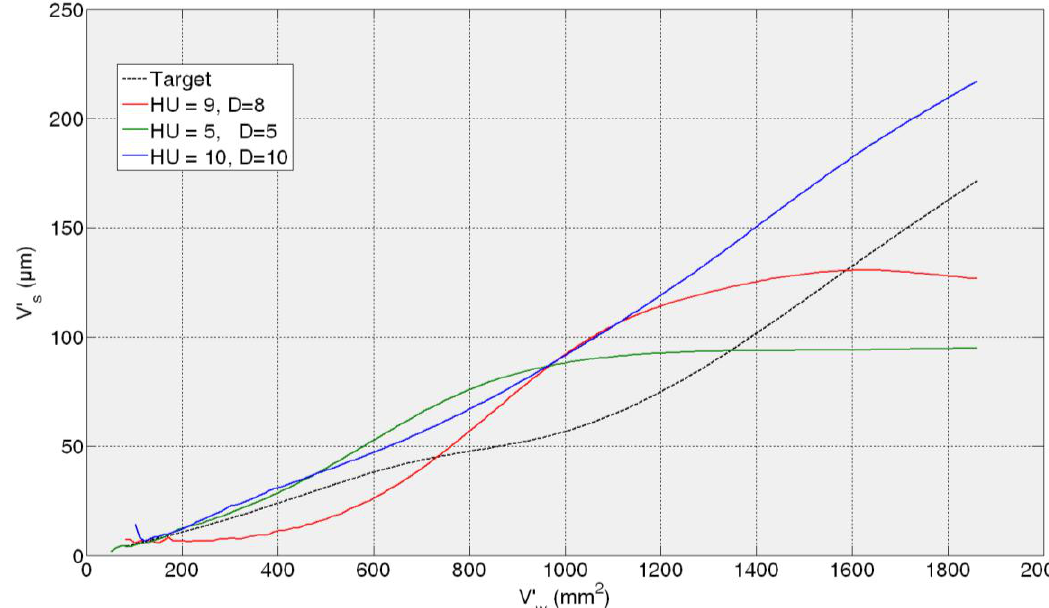
Figure 9. Generalization capability of the three preselected configurations . Test experiment : 82AA36G6VW q = 60; Q' = 2.5. s